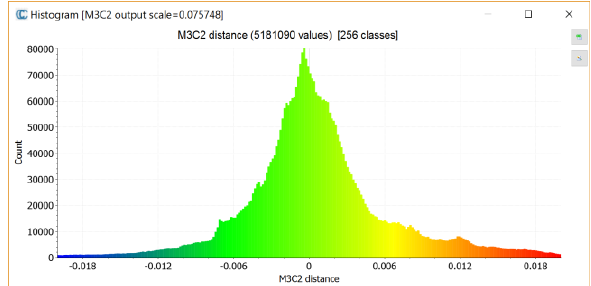
Figure 10. Histogram of distance (m) between the points of the two models obtained by M3C2 tool after ICP